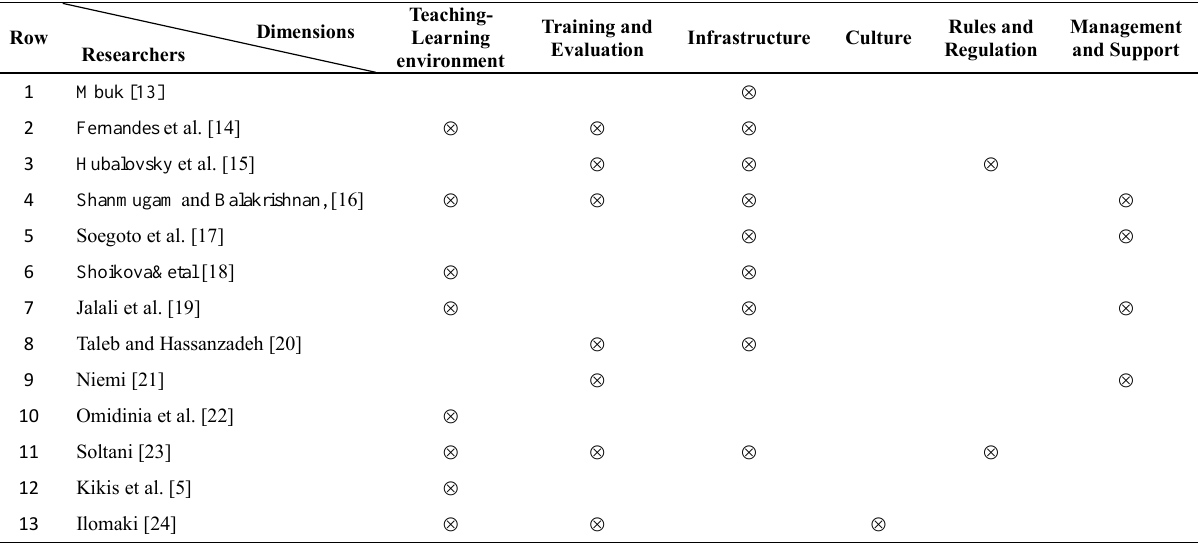
Table 1 . Comparison of models and researches presented in the field of intelligent development